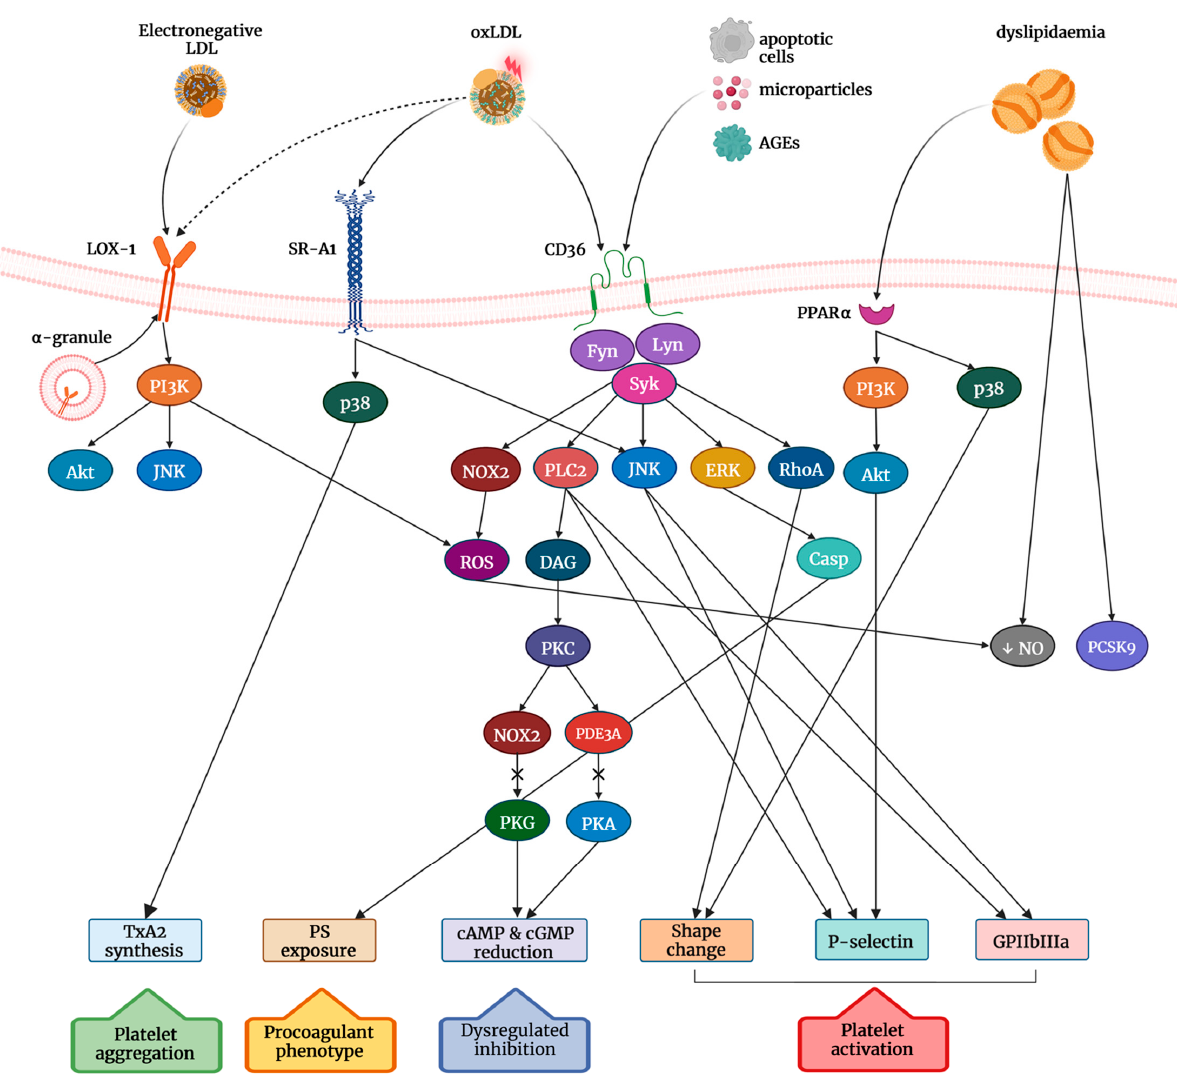
Figure 2. Signaling pathways enhanced by oxLDL binding to platelet SRs and PPAR α expression in dyslipidaemia. Abbreviations: LDL: low density lipoprotein; LOX-1: lectin-like oxidized low-density lipoprotein receptor-1; PI3K: phosphoinositide 3-kinase; Akt: Protein kinase B; JNK: c-Jun N-terminal kinase; oxLDL: oxidized LDL; SR-A1: scavenger receptor A1; TxA2: thromboxane A2; CD36: cluster of differentiation 36; AGEs: advanced glycation end products; SYK: spleen tyrosine kinase; Nox2: NADPH oxidase 2; PLC2: phospholipase C2; ERK Extracellular signal-regulated ki- nase; RhoA: Ras homolog family member A; ROS: reactive oxygen species; DAG: diacylglycerol; Casp: caspase; PKC: protein kinase C; PDE3A: phosphodiesterase 3A; PKG protein kinase G; PKA protein kinase A; cAMP: cyclic adenosine monophosphate; cGMP: cyclic guanosine monophos- phate; PPAR α : peroxisome proliferator-activated receptor alpha; NO: nitric oxide; PCSK9: propro- tein convertase subtilisin/kexin type 9; GPIIbIIIa: glycoprotein IIb/IIIa; PS: phosphatidylserine.